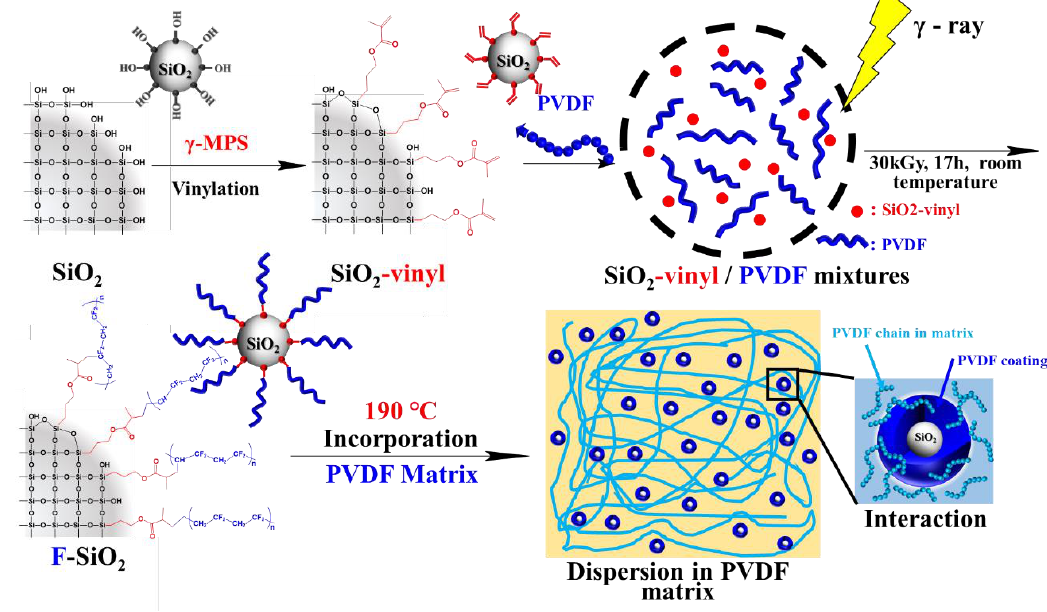
Figure 1. Schematic diagram of the surface modified silica nanoparticles with polyvinylidene fluoride (PVDF) coating by using radiation-induced graft polymerization under a wide temperature range and the distribution of F-SiO 2 in the PVDF matrix.